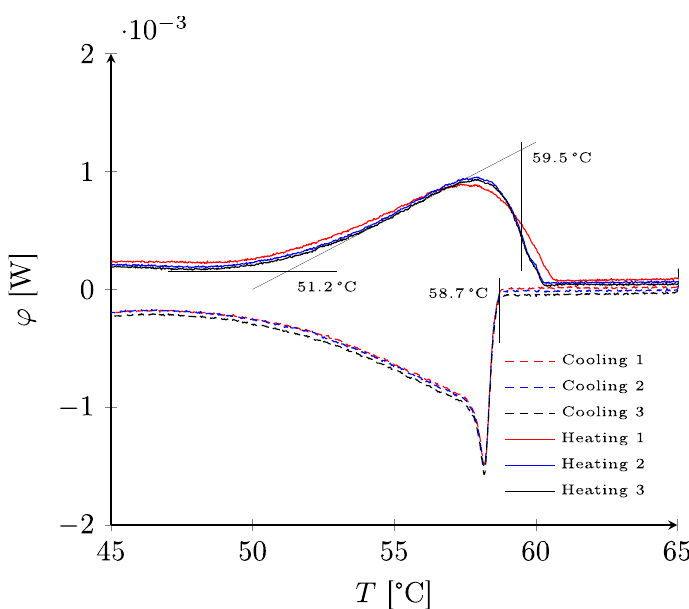
Figure 4. Thermograms for paraffin RT58.